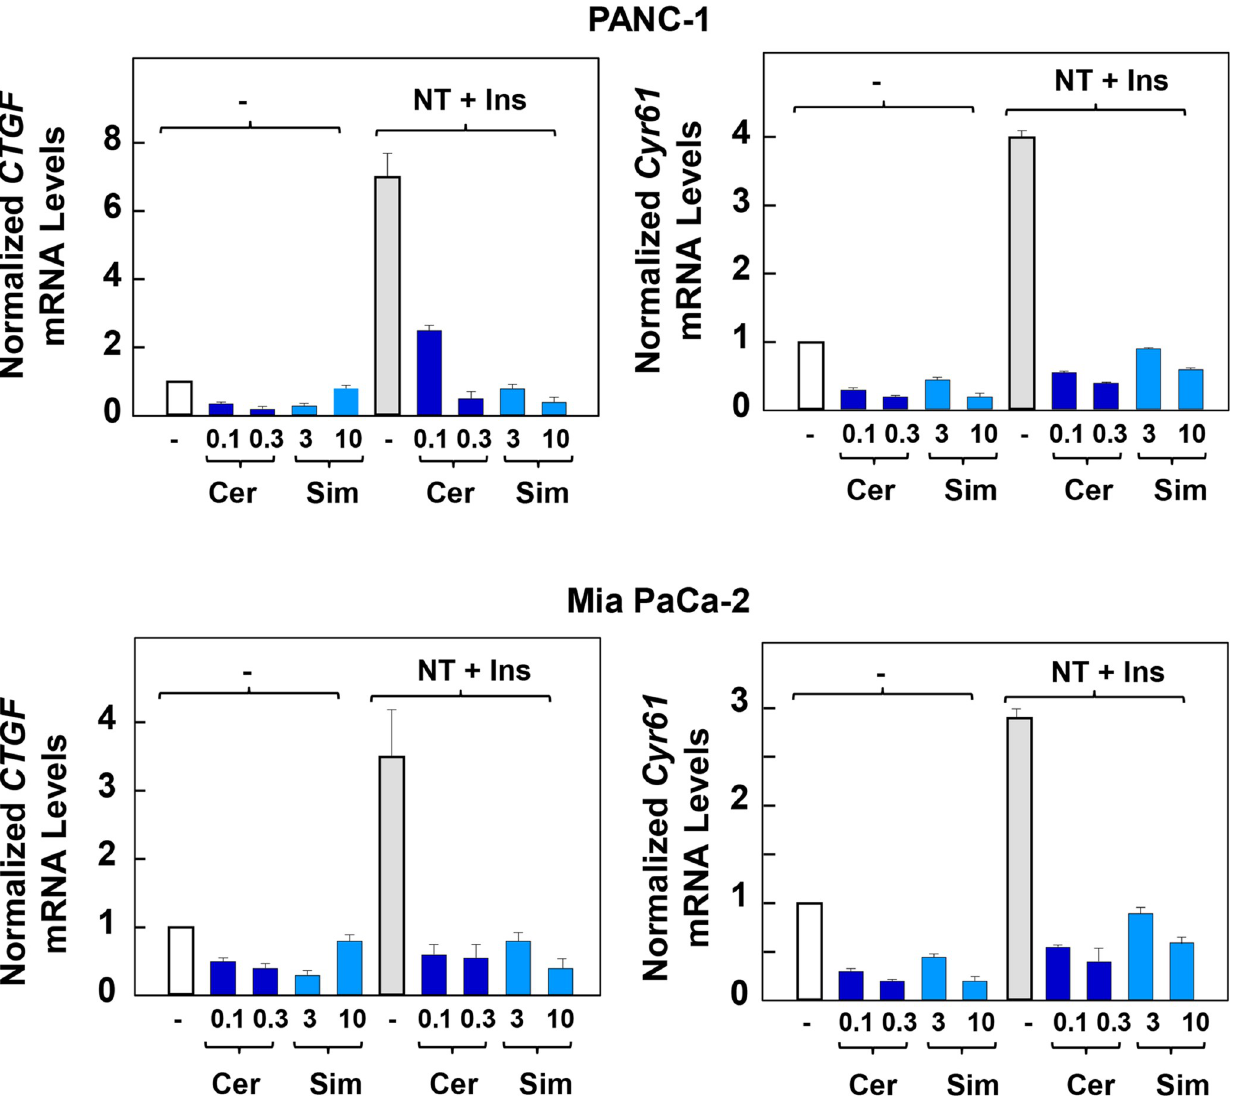
Fig 3. Exposure to lipophilic statins inhibits the expression of CTGF and CYR61 induced by stimulation with neurotensin and insulin in PDAC cells. Confluent cultures of PANC-1 cells (upper panel) or MiaPaca-2 cells (lower panel) were incubated for 24 h either without or with cerivastatin (Cer) at 0.1 and 0.3 μ M or simvastatin (sim) at 3 and 10 μ M, as indicated. The cultures were then stimulated either without (-) or with a combination of 5 nM neurotensin and 10 ng/ml insulin (NT+Ins) for 60 min. RNA was isolated and the relative levels (n = 3) of CTGF or CYR61 mRNA compared with 18s mRNA was measured by RT-qPCR. Data are presented as mean ± SEM. Similar results were obtained in 3 independent experiments. Exposure to cerivastatin and simvastatin significantly decreased relative mRNA levels of CTGF and CYR61 as compared with controls ( �� P < 0.01) as shown by paired